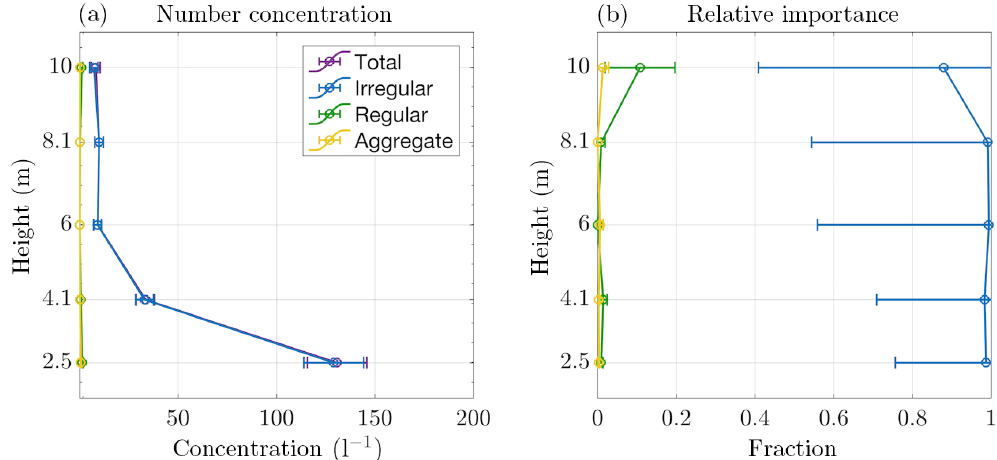
Figure 8. Vertical profile of the concentration (a) and the fraction (b) of individual ice crystal habits for the profiles between 19:10 and 20:20UTC on 4 February 2017. The concentration of regular crystals and aggregates is below 1L − 1 for all heights. For the fraction, the ICNCs of individual habits were divided by the total ICNCs. The circles represent the mean and the error bars represent the standard error of the mean.